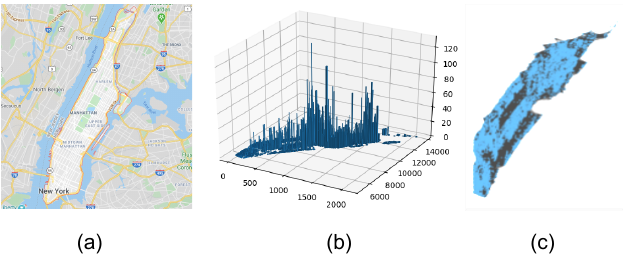
Figure 14. Manhattan Island visibility graph: ( a ) a map of Manhattan Island in New York, ( b ) a chart of all the buildings in that map (using OSM); and ( c ) the building visibility graph.